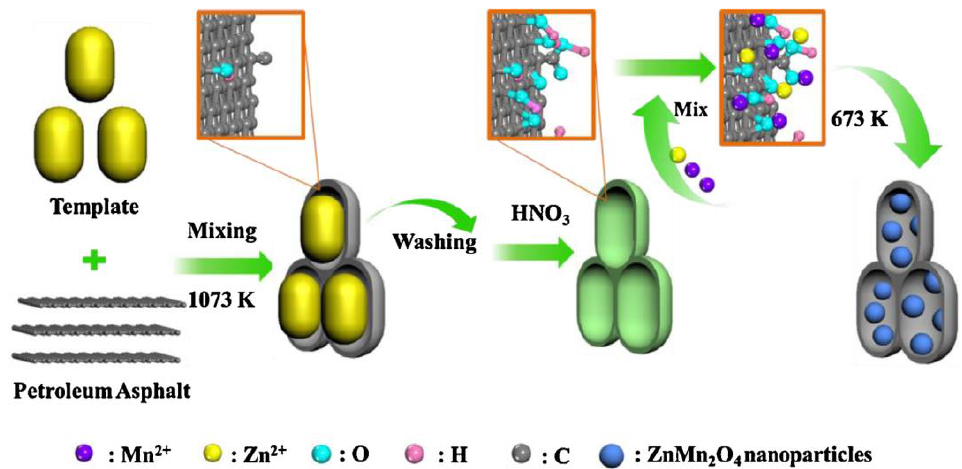
Figure 22. Schematic synthesis of 3D porous carbon framework made of asphaltene and incorporation with ZnMn 2 O 4 (reprinted with permission from Ref. [82]).